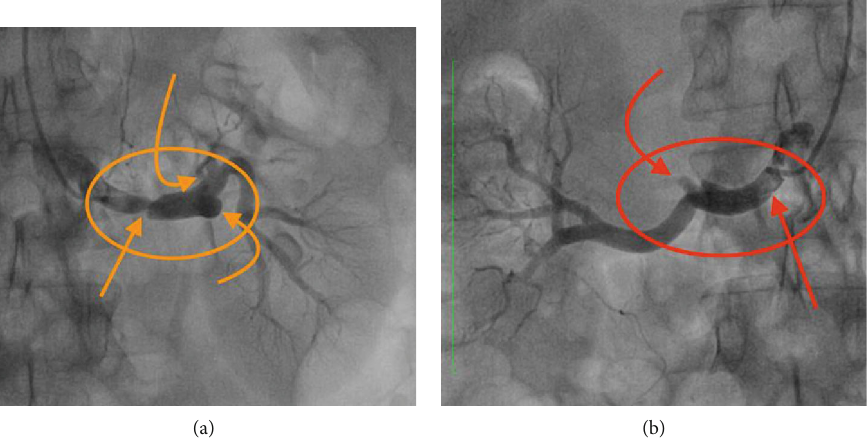
Figure 3: Conventional catheter selective angiography of the left renal artery (a) reveals overall reduced perfusion in the upper half of the left kidney with a focal thrombosis in the mid-left main renal artery (orange circle) and dissection fl ap, causing signi fi cant stenosis (orange straight arrow); demonstrates complete thrombosis of the middle segmental branch of the left renal artery (orange curved arrow) and near-complete stenosis of the upper segmental branch (orange angled arrow); and (b) reveals reduced perfusion in the lower 1/3 rd of the right kidney with focal expansion of the right renal artery (red circle) with dissection fl ap (red straight arrow) and with near-complete stenosis of the segmental branch (red curved arrow) supplying the lower pole and part of the upper